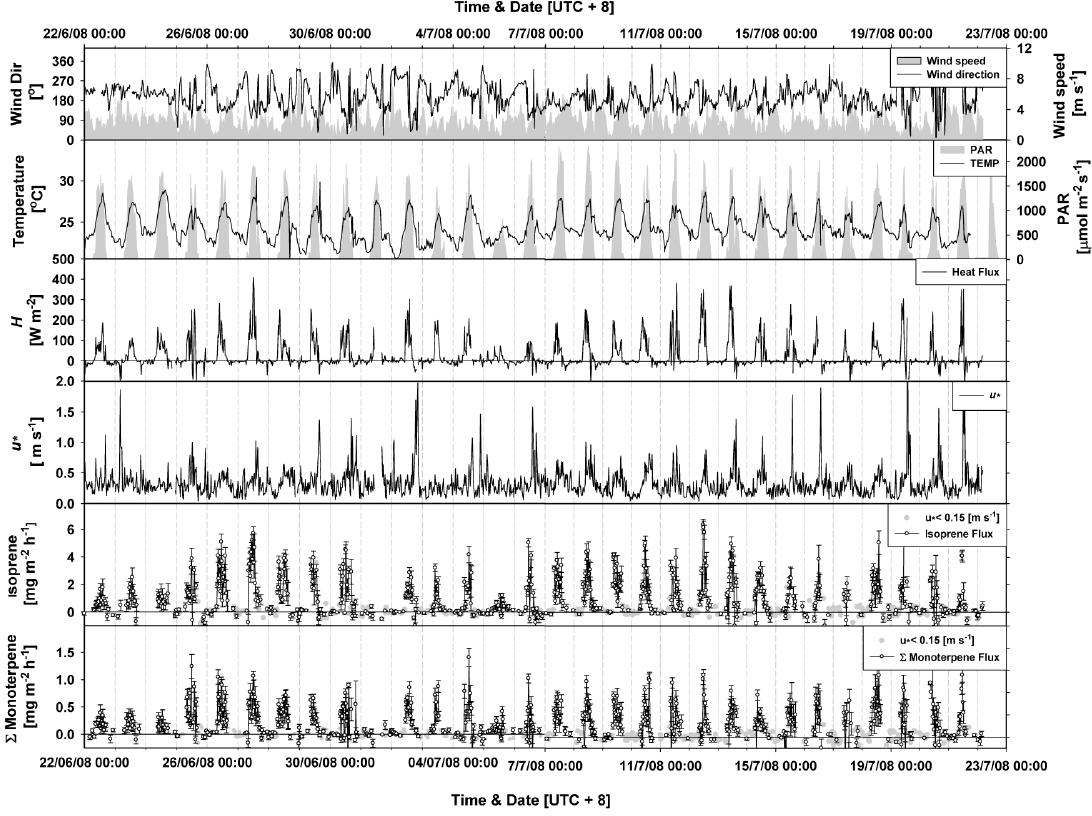
Fig. 6b. Summary of the meteorology and main VOC fluxes during the second intensive OP3 field campaign (OP3 – III) which took place during June and July, 2008. Measurement instrumentation as above. VOC flux data recorded during periods of low turbulence ( u ∗ < 0.15ms − 1 ) were rejected from the final analysis, but are shown here as grey